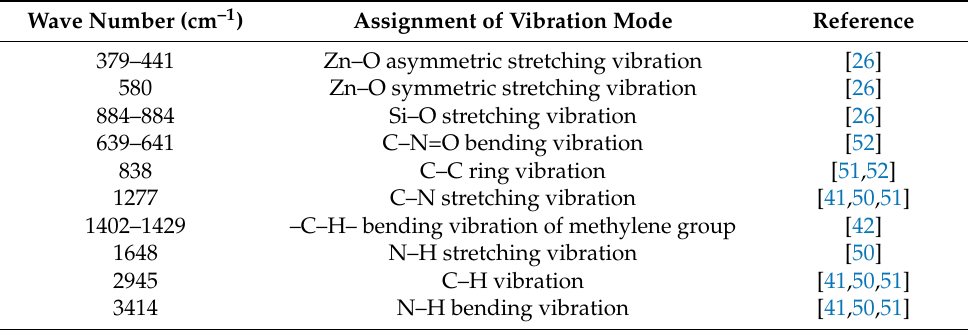
Table 2. Summary of the FT–IR absorption features and their